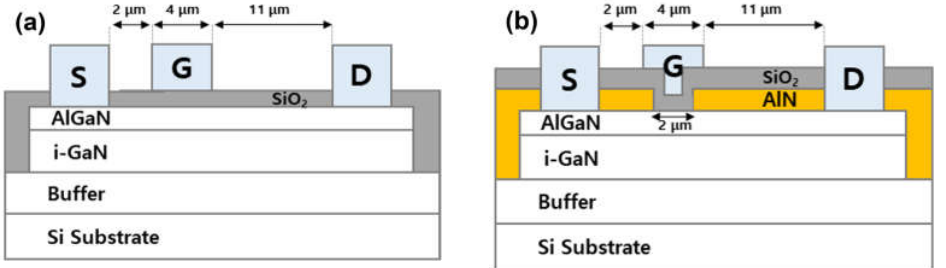
Figure 6. Cross-sectional schematics of thin-AlGaN/GaN MIS-HFETs fabricated ( a ) without and ( b ) with PEALD AlN film.